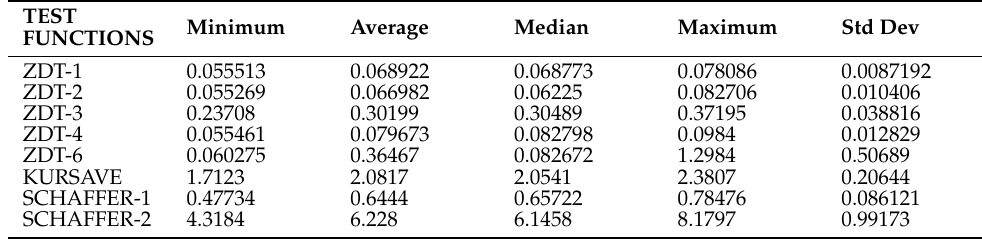
Table 5. Results of SPACINGMETRICS on test functions.